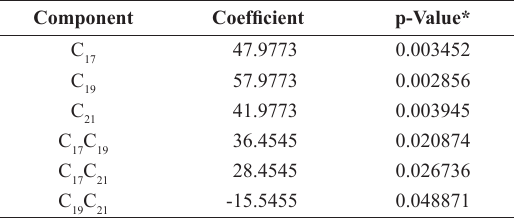
Table 5. Regression analysis for CO samples.